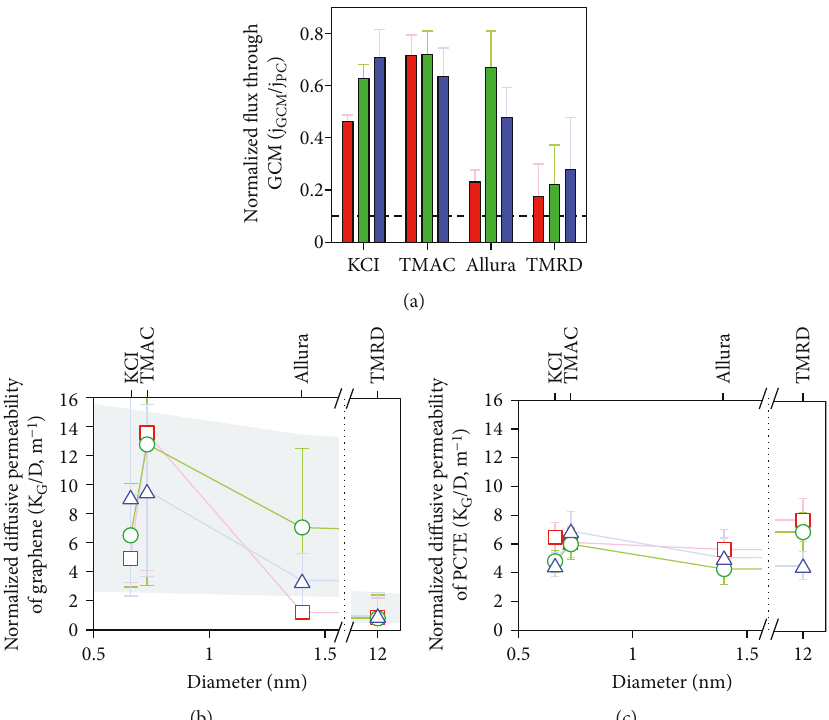
Figure 4: (a) Di ff usive fl ux of molecules through graphene-PCTE membranes normalized by that through the bare PCTE support. (b) Permeability of graphene single layer normalized by the di ff usivity of the di ff erent molecules. The transport of the 12nm diameters TMRD molecule was signi fi cantly attenuated compared to the smaller molecules. (c) Measured permeability of the PCTE support normalized by the di ff usivity. Reprinted with permission from